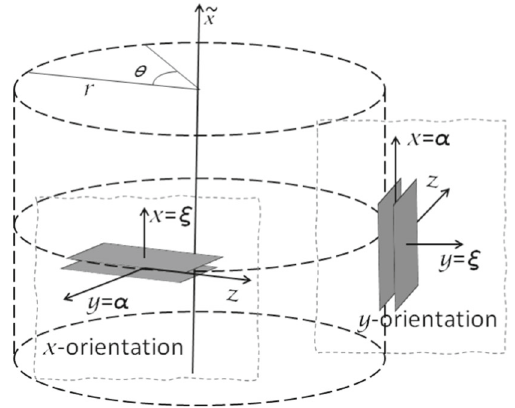
Fig. 1 Orientations of the Casimir apparatus for the cylindrically sym- metric